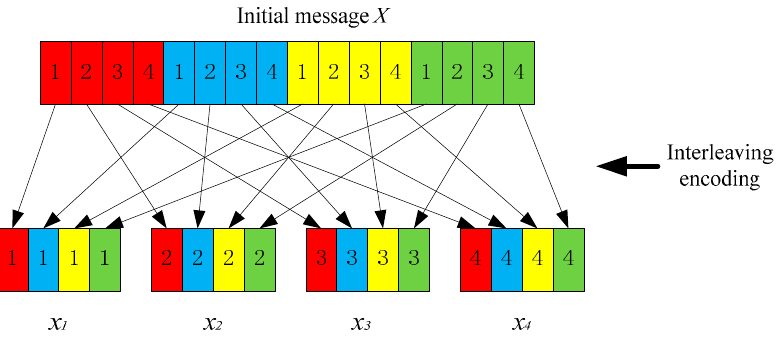
Figure 4. Message splitting based on interleaving encoder.